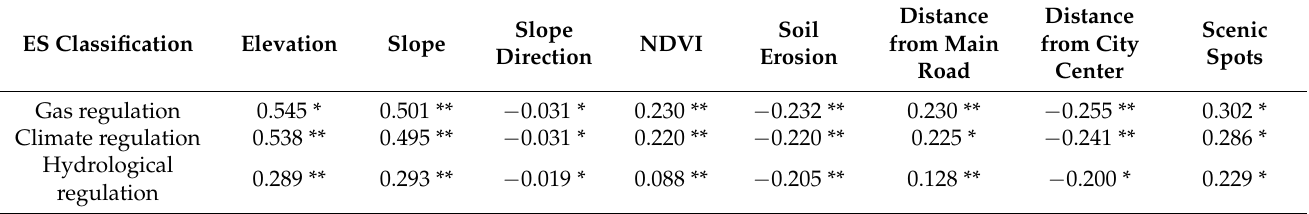
Table 7. Correlation analysis of urban agglomeration land expansion factors and individual ESVs. * Statistically significant at 10%; ** Statistically significant at